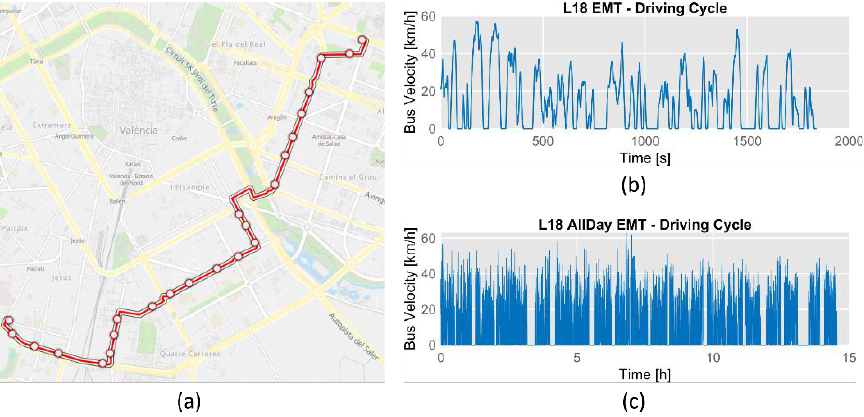
Figure 16. Route 18 (EMT Valencia): ( a ) route, ( b ) one-way driving cycle, ( c ) all-day driving cycle.